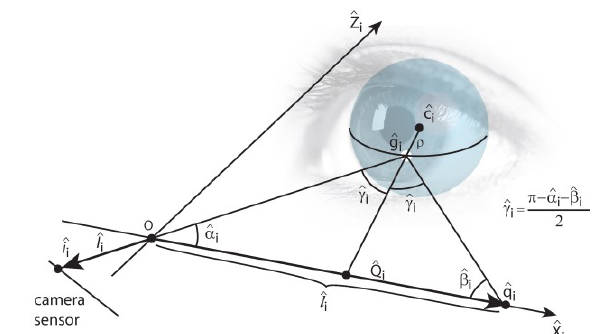
Figure 4. The auxiliary coordinate system, used for esti- mating the cornea center from glints. The origin O is at the optical center (i.e., the focal point) of the utilized pin- hole camera model. Here 𝑞 ̂ is the location of i’ th LED 𝑖 light source, 𝑔 ̂ is the corresponding glint on the corneal 𝑖 sphere, 𝑖 ̂ is the image of the i’ th glint on the image plane, 𝑖 and 𝑐 ̂ is the cornea center. Each LED, and the corre- 𝑖 sponding glint, has their own coordinate system with the shared origin. The figure is adapted from Hennessey et al.